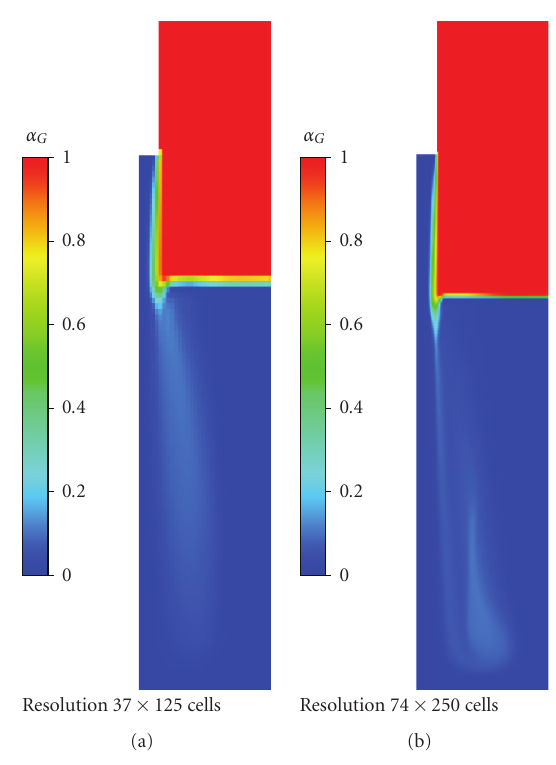
Figure 20: Gas void fraction for two di ff erent grid resolutions, C D = 0 . 1, representative